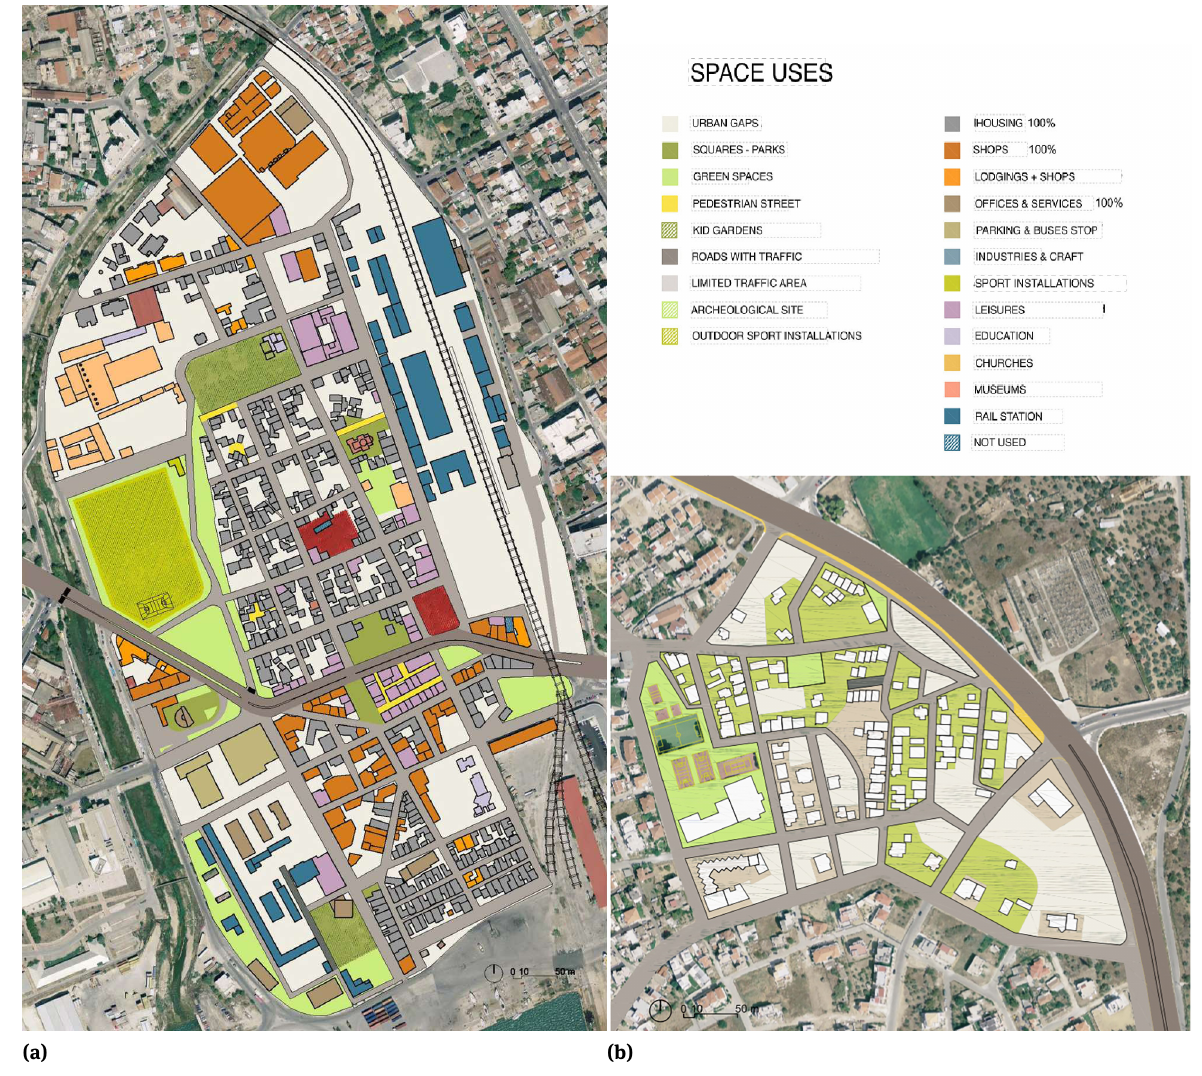
Figure 7: Map of the predominant uses, (a) Old city (“Palia”) and (b) Karagatz district, Volos U.A